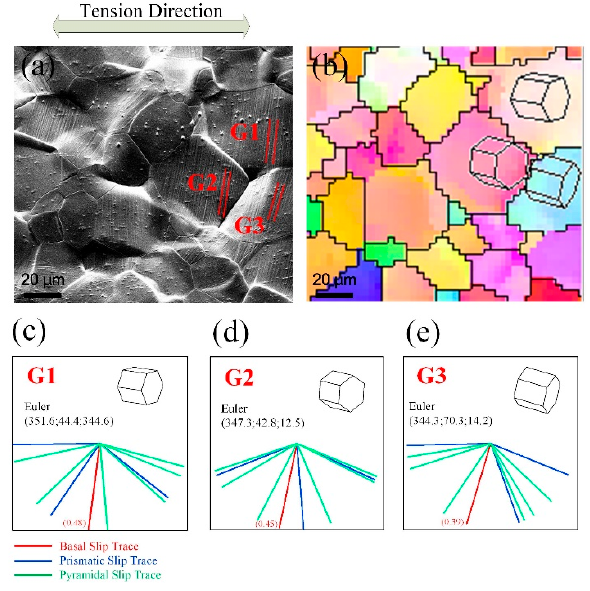
Figure 4. ( a ) SEM micrograph of Mg–8.0Gd–3.0Y–0.5 Zr alloy after tension test at strain of 0.1; ( b ) the corresponding IPF map; ( c ) possible slip trace directions in Grain 1; ( d ) possible slip trace directions in Grain 2; ( e ) possible slip trace directions in Grain 3.